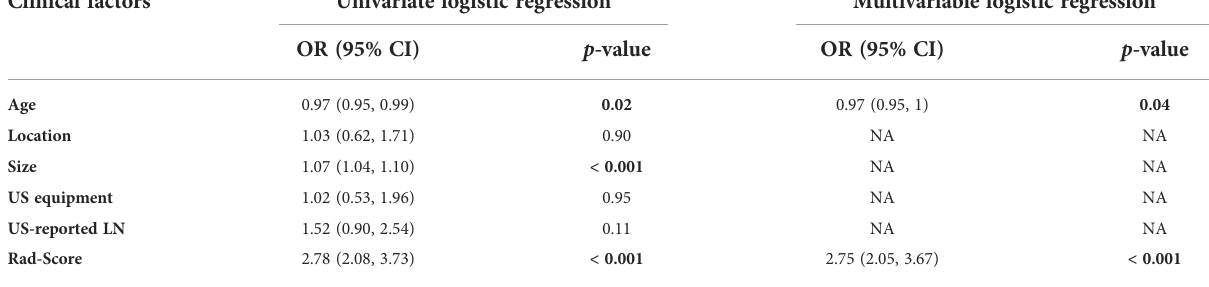
TABLE 5 The results of logistic regression. Clinical factors